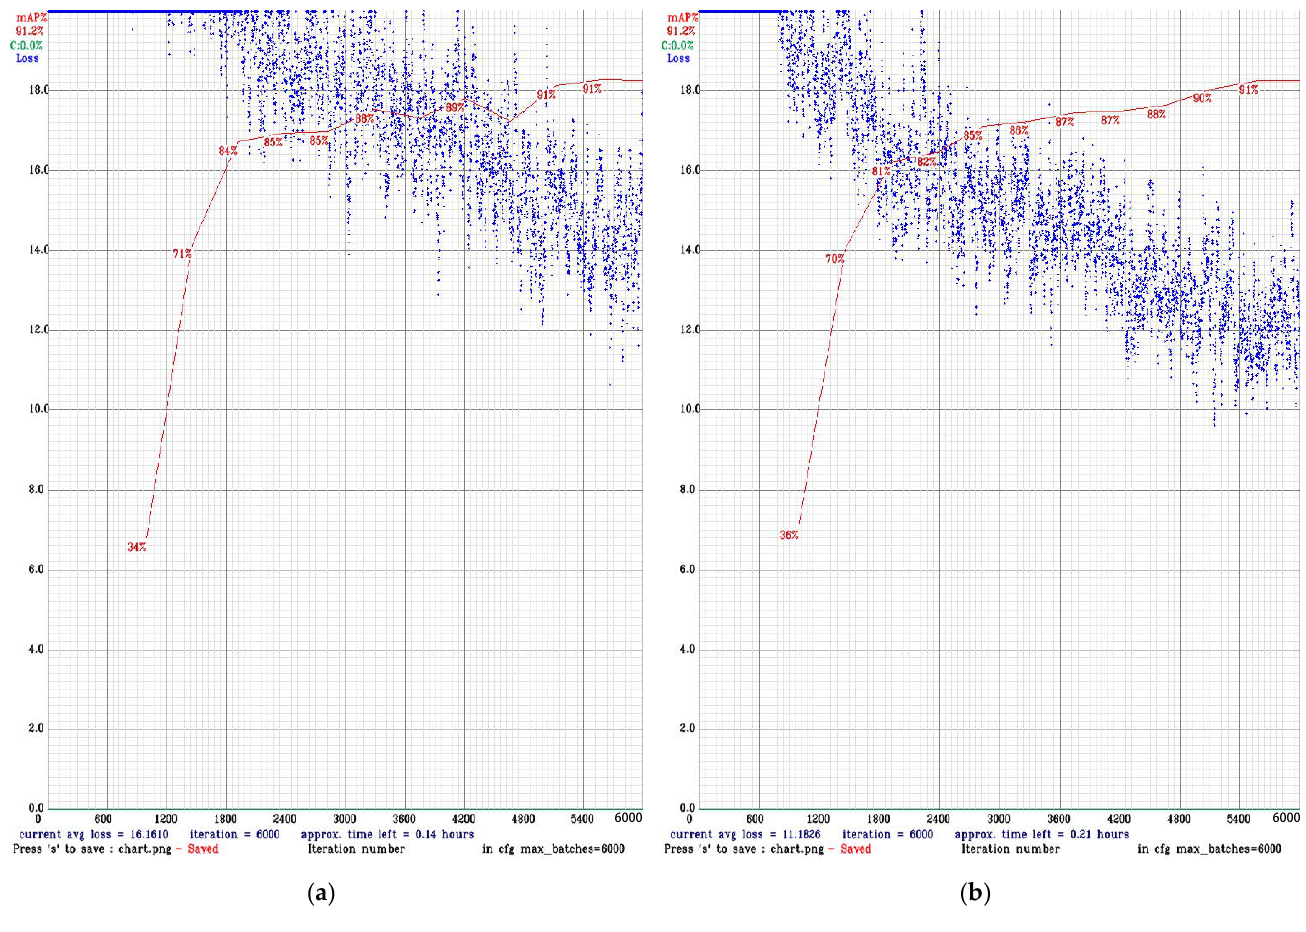
Figure 8. RTX 2060 trained the best performing models: mAP vs. avg. loss. ( a ) Model with subdivision of 32 and image resolution of 512 × 512 with default hyperparameters settings showing mAP of 91.2 and avg. loss of 16.2. ( b ) Model with subdivision of 32 and image resolution of 608 × 608 with default hyperparameters settings showing mAP of 91.2 with reduced avg. loss of 11.2. It can be observed from the above that the model performed best on RTX 2060 when Table 4. Model 2: Scaled-YOLOv4 Optimization Configuration, and Parameter Tuning using GPU having a subdivision of 32 and an image resolution of 608 × 608. RTX